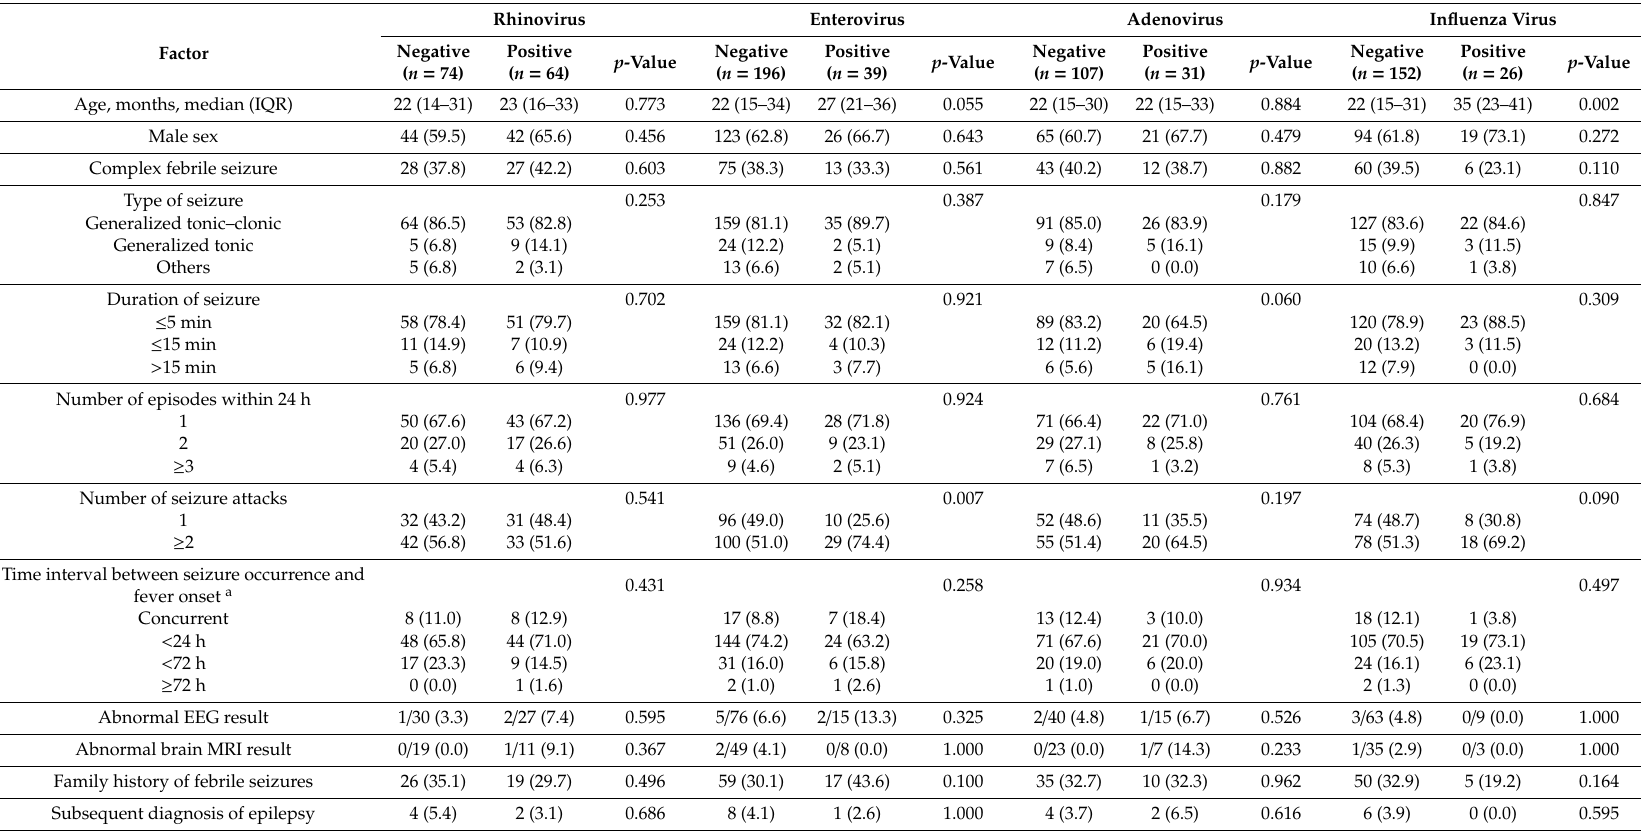
Table 4. Comparisons between children with positive and negative results for each respiratory